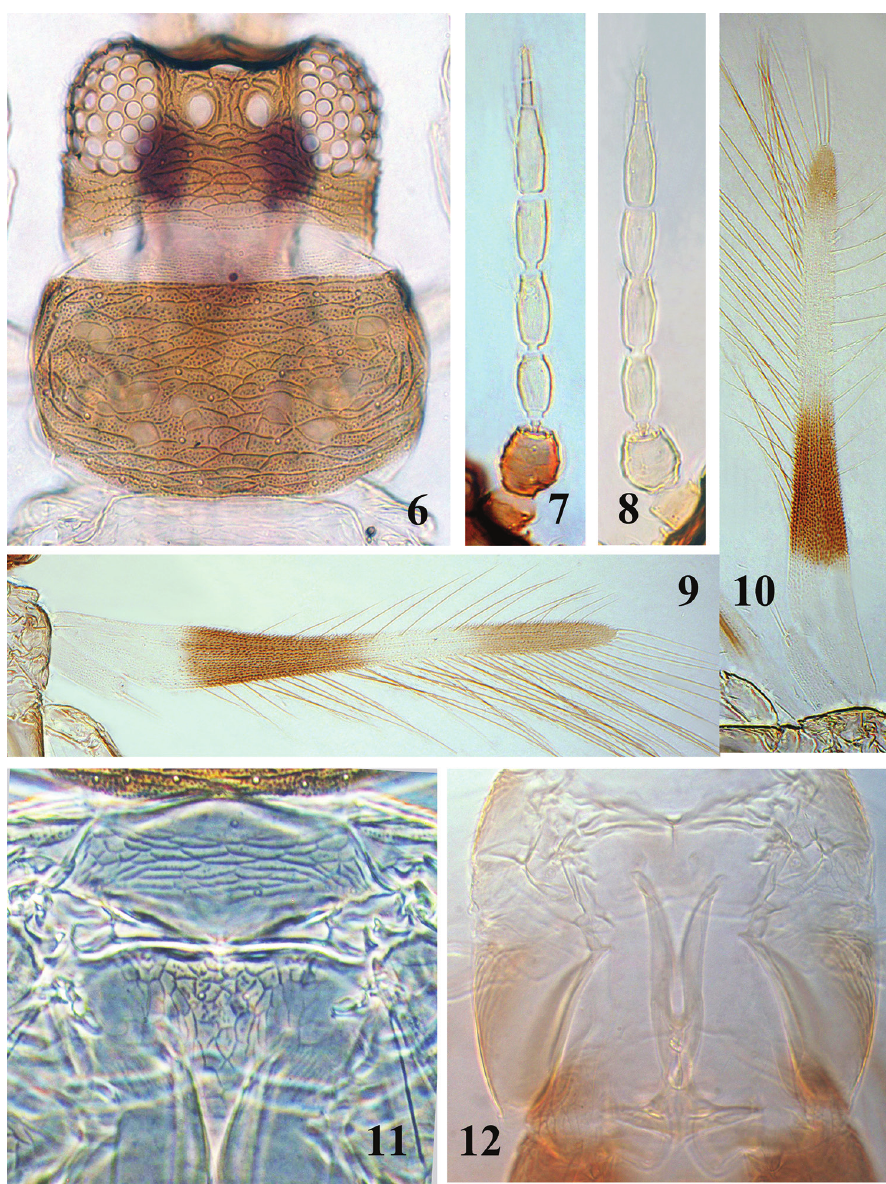
complete and narrower at middle. Mesonotum (Fig. 11) with transverse anastomosing striae without internal wrinkles or granules within the reticules, a pair of campani- form sensilla on anterior fourth, median setal pair situated submedially.